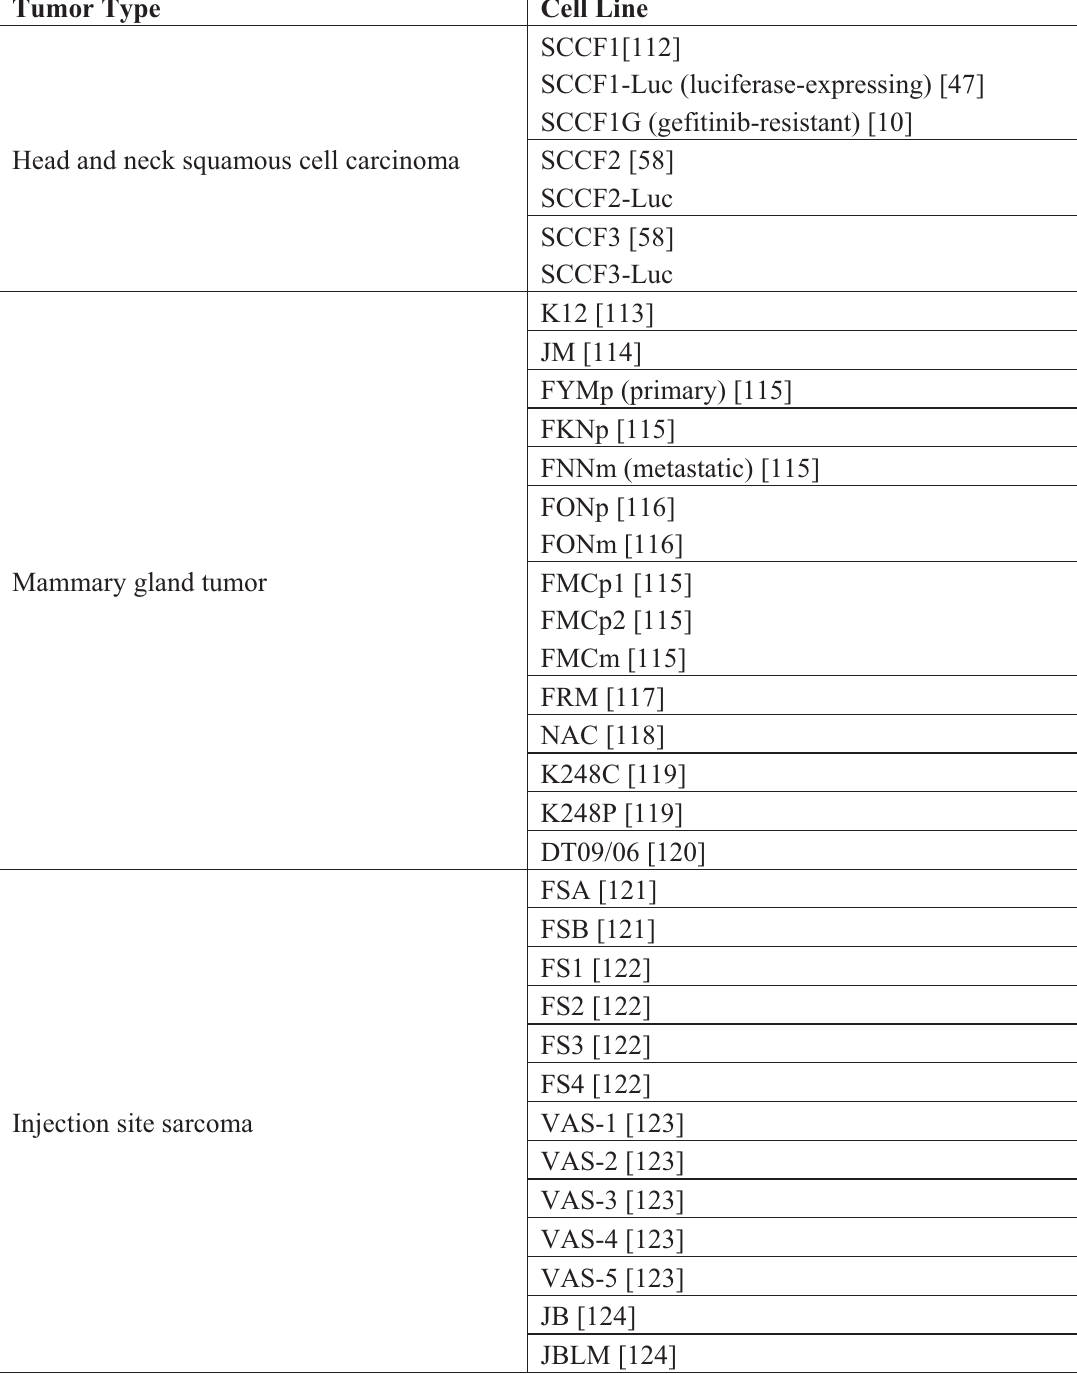
Table 1. Feline squamous cell carcinoma, mammary gland carcinoma and injection-site sarcoma cell lines used in published